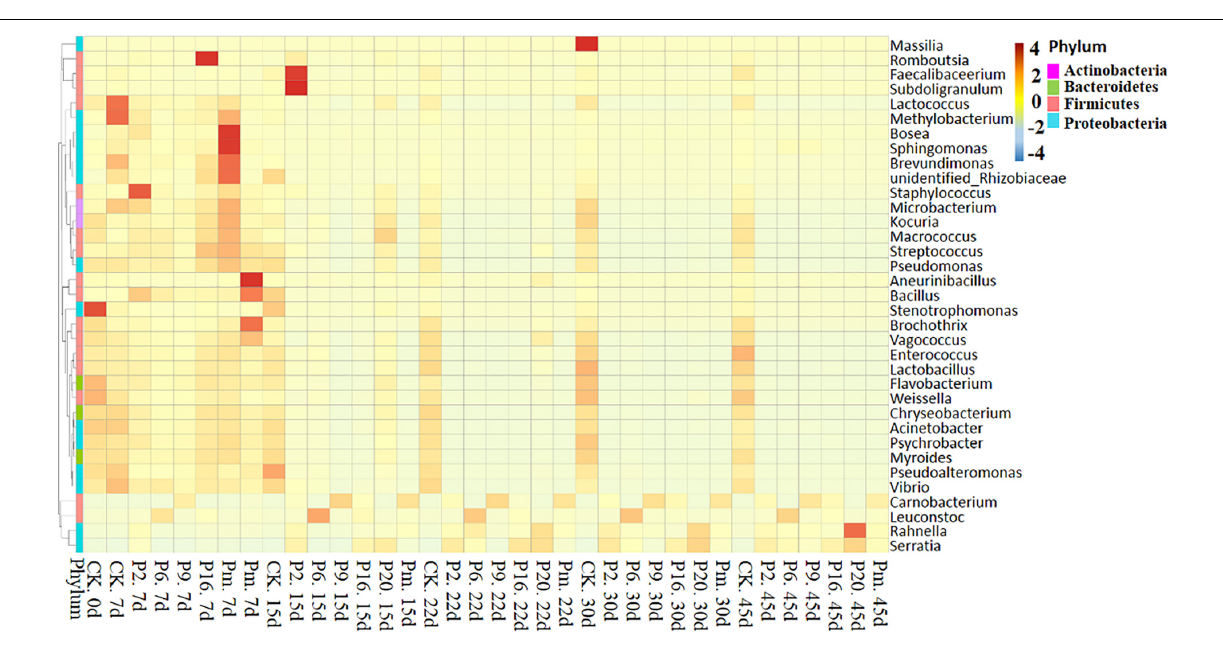
FIGURE 4 | Heatmap showing the changes in the microbial communities of bacon inoculated with potential spoilage bacteria. The group heatmaps represent a homogenization of numerical values of corresponding points. CK, Control; P2, Staphylococcus xylosus ; P6, Leuconostoc mesenteroides ; P9, Carnobacterium maltaromaticum ; P16, Leuconostoc gelidum ; P20, Serratia liquefaciens ; Pm, The five strains in